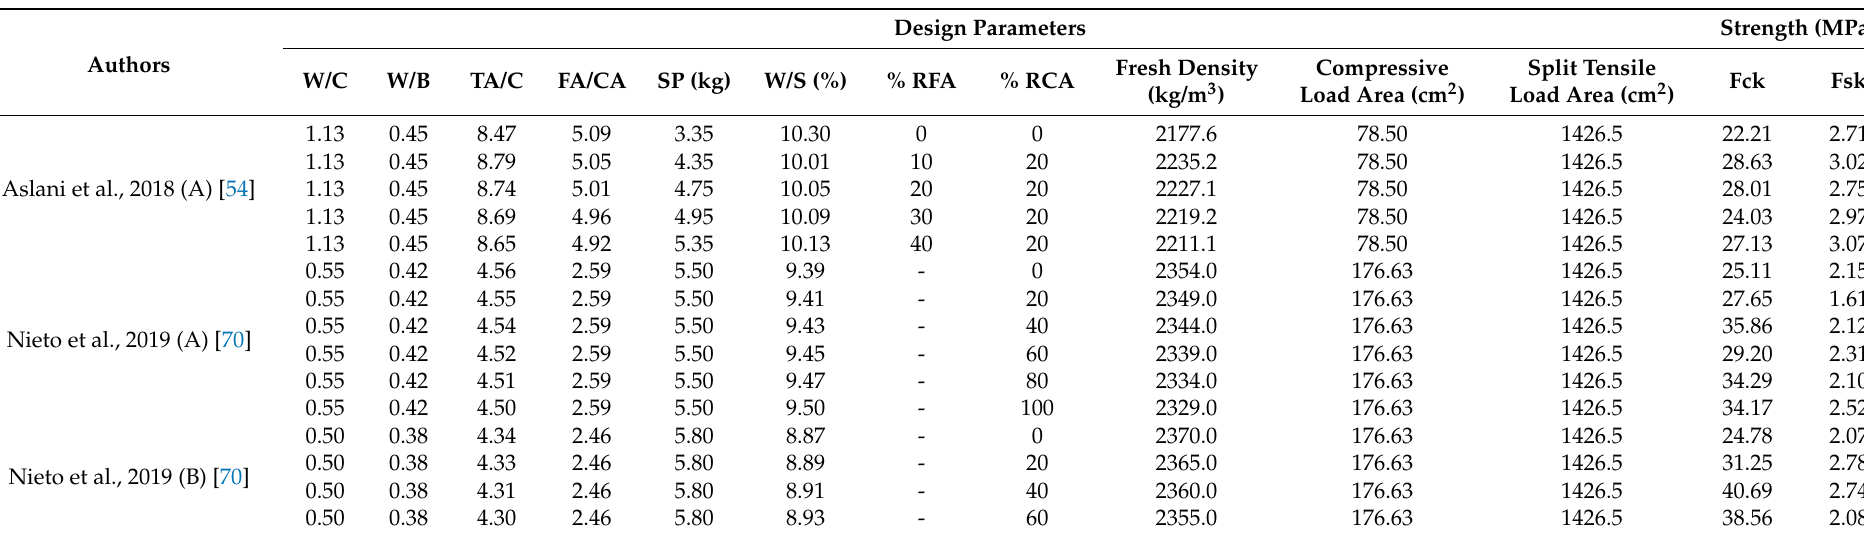
Table 6. Family VI (Compressive strength range–20 MPa to 30 MPa) design parameters according to